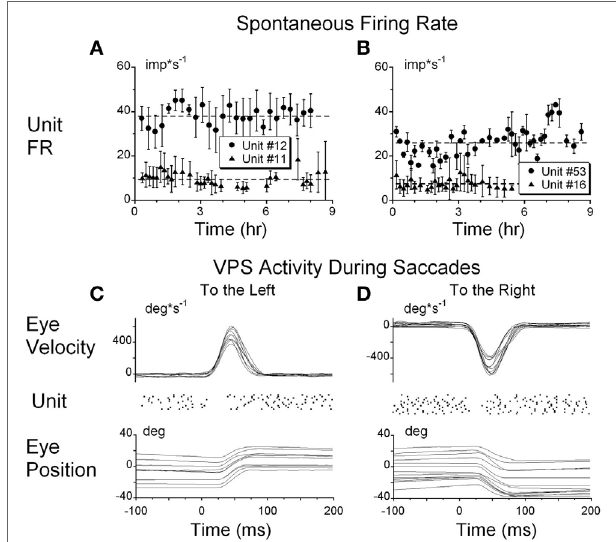
FigUre 2 | (a,B) Typical examples of the resting firing rates from several neurons during the experiments. (c,D) Raster’s of firing rate of the position-vestibular-pause (PVP) neuron during spontaneous saccades to the left (c) and to the right (D) . This PVP neuron paused it firing at the beginning of each